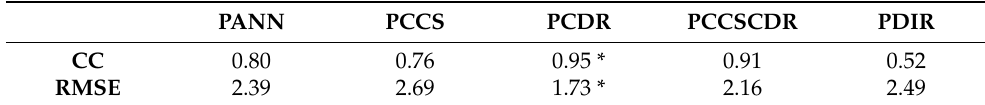
possessing highest value of RMSE or lowest value of CC is marked by